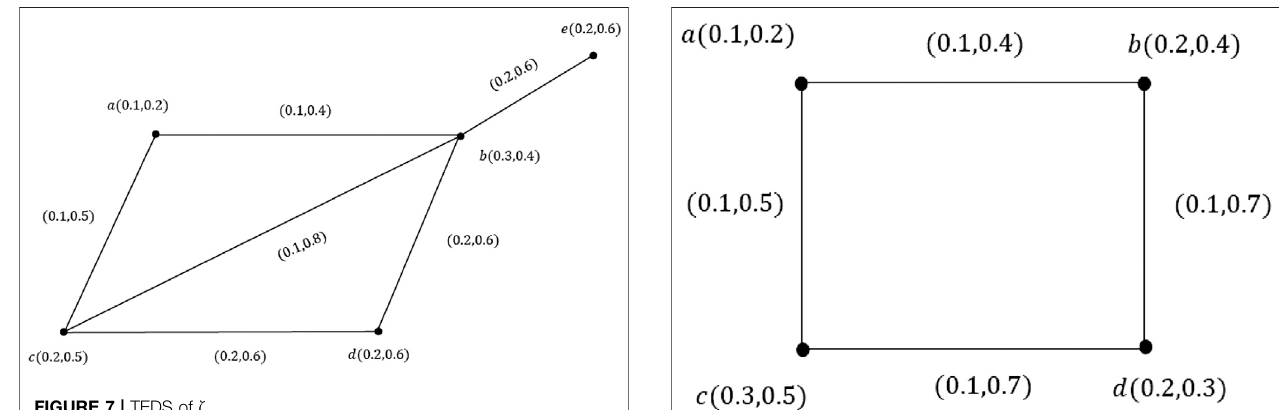
FIGURE 7 | TEDS of ζ